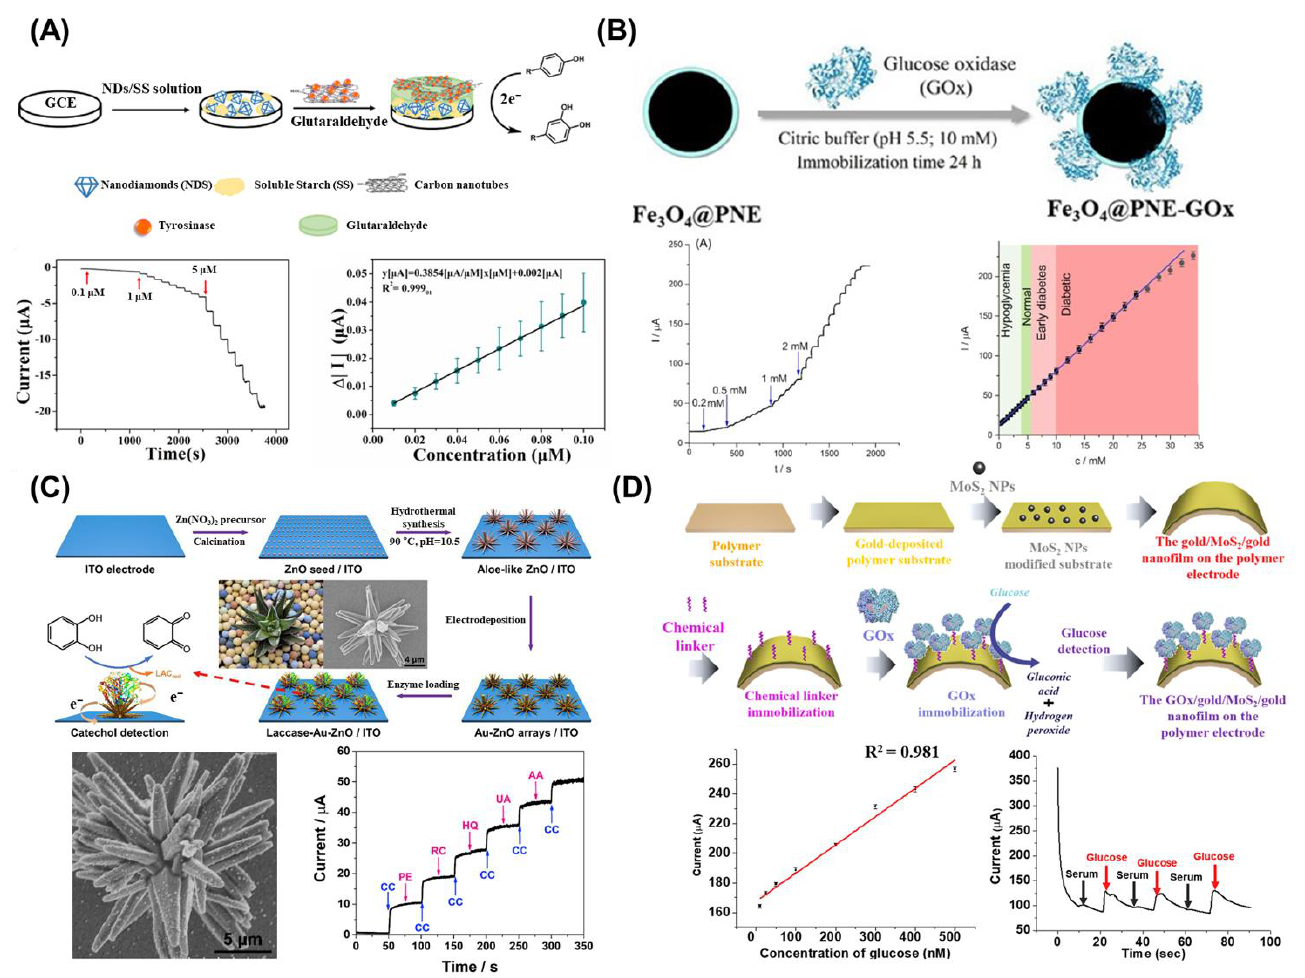
Figure 4. ( A ) Schematic illustration of the fabrication of nanobiosensor composed of Tyr, ND, and CNT, and electrochemical phenol detection results, Reprinted with permission from ref. [79] . Copyright © 2022 by the authors, ( B ) Scheme for encapsulation of the MNP by PNE and immobilization of GOx, and amperometric response and linear response plot for glucose detection in the presence of a different concentration of the glucose, Reprinted with permission from ref. [84] . Copyright © 2022 Elsevier B.V., ( C ) Schematic diagram of catechol nanobiosensor fabrication by using Au-ZnO nanocrystal arrays and Laccase, scanning electron microscopy (SEM) image of Au-ZnO nanocrystal, and its selective electrochemical catechol (CC) detection property, Reprinted with permission from ref. [87] . Copyright © 2020 Elsevier B.V., ( D ) Schematic image of flexible GOx/Au/MoS /Au 2